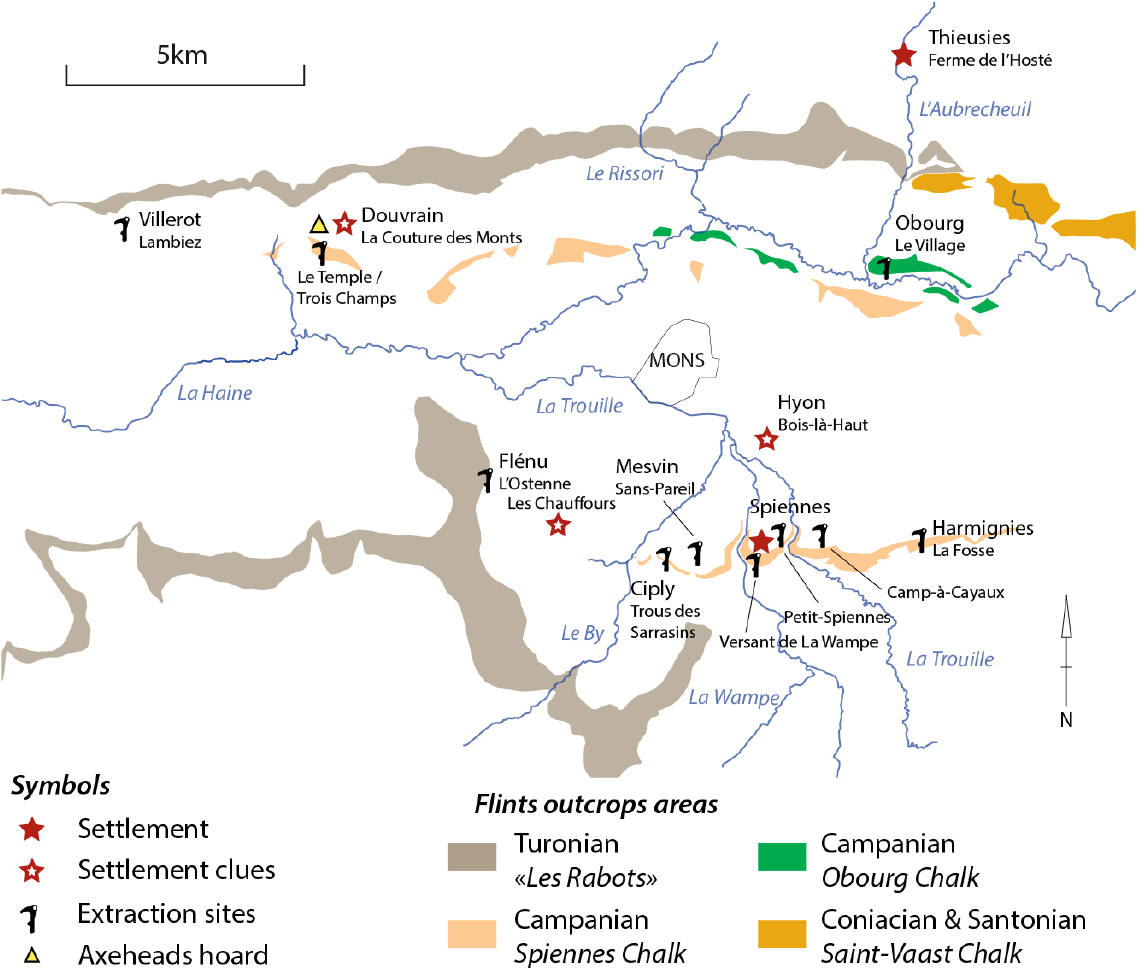
Figure 1. Extraction sites and settlements in the Mons Basin (Modified after Collet